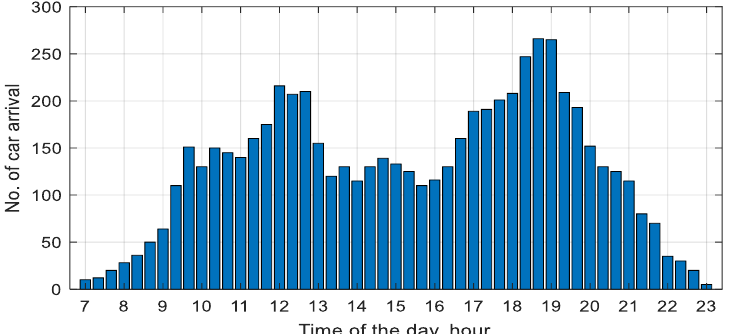
Figure 4: Average car arrival patterns over hours in a day. The parking data model for several days from 7:00 am to 11:00